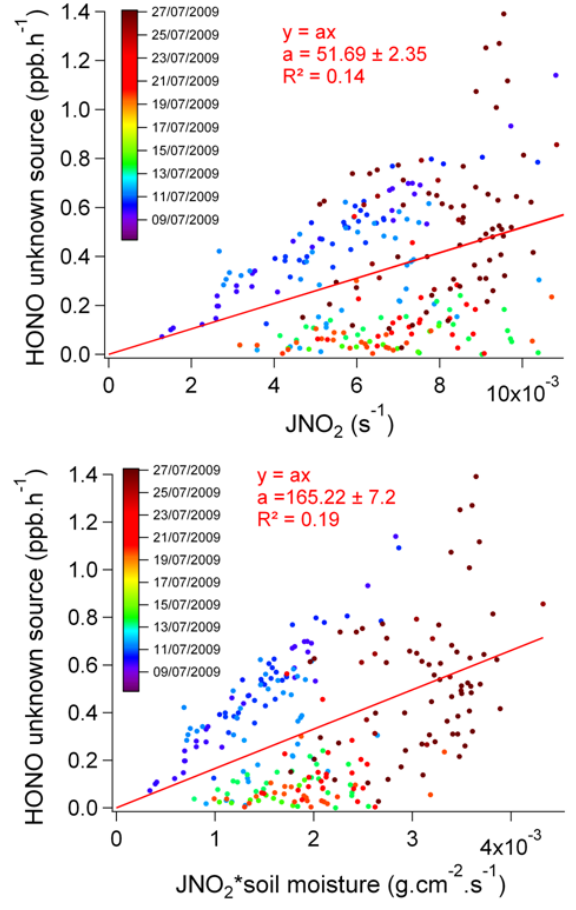
Fig. 11. Correlations between the unknown HONO source and measured J (NO 2 ) and the product between measured J (NO 2 ) and soil moisture measured at 5cm below ground surface, during the MEGAPOLI summer campaign at SIRTA observatory. The dots of both correlations have been coloured as a function of the